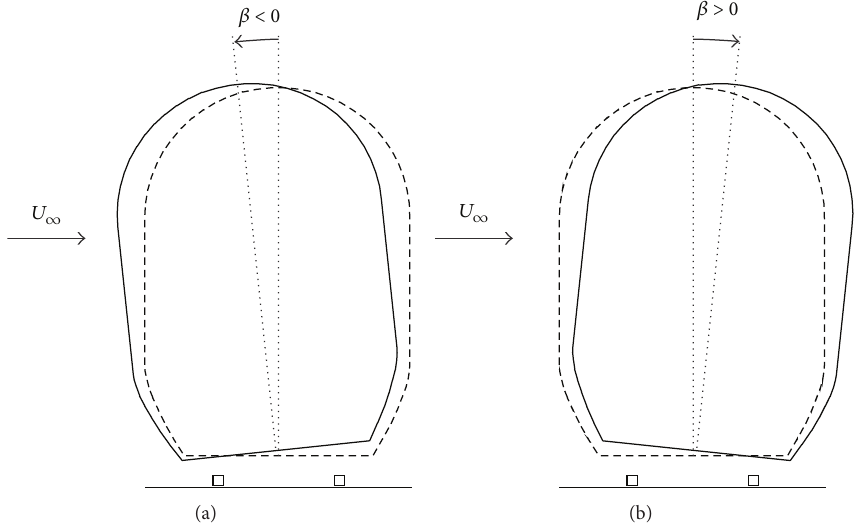
Figure 2: Coach rolling angle, 𝛽 . Negative values of the rolling angle correspond to a counterclockwise rotation around 𝑦 -axis (a), whereas positive values correspond to a clockwise rotation around 𝑦 -axis